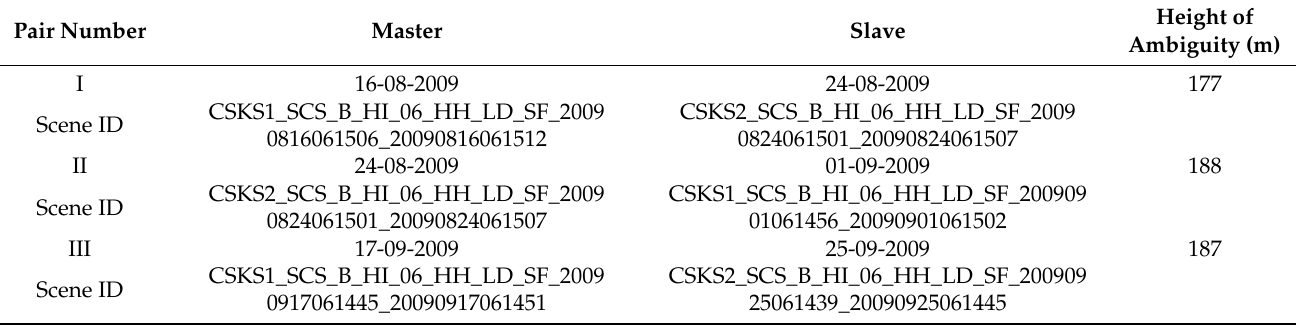
Table 3. The three processed SAR pairs numbered in temporal